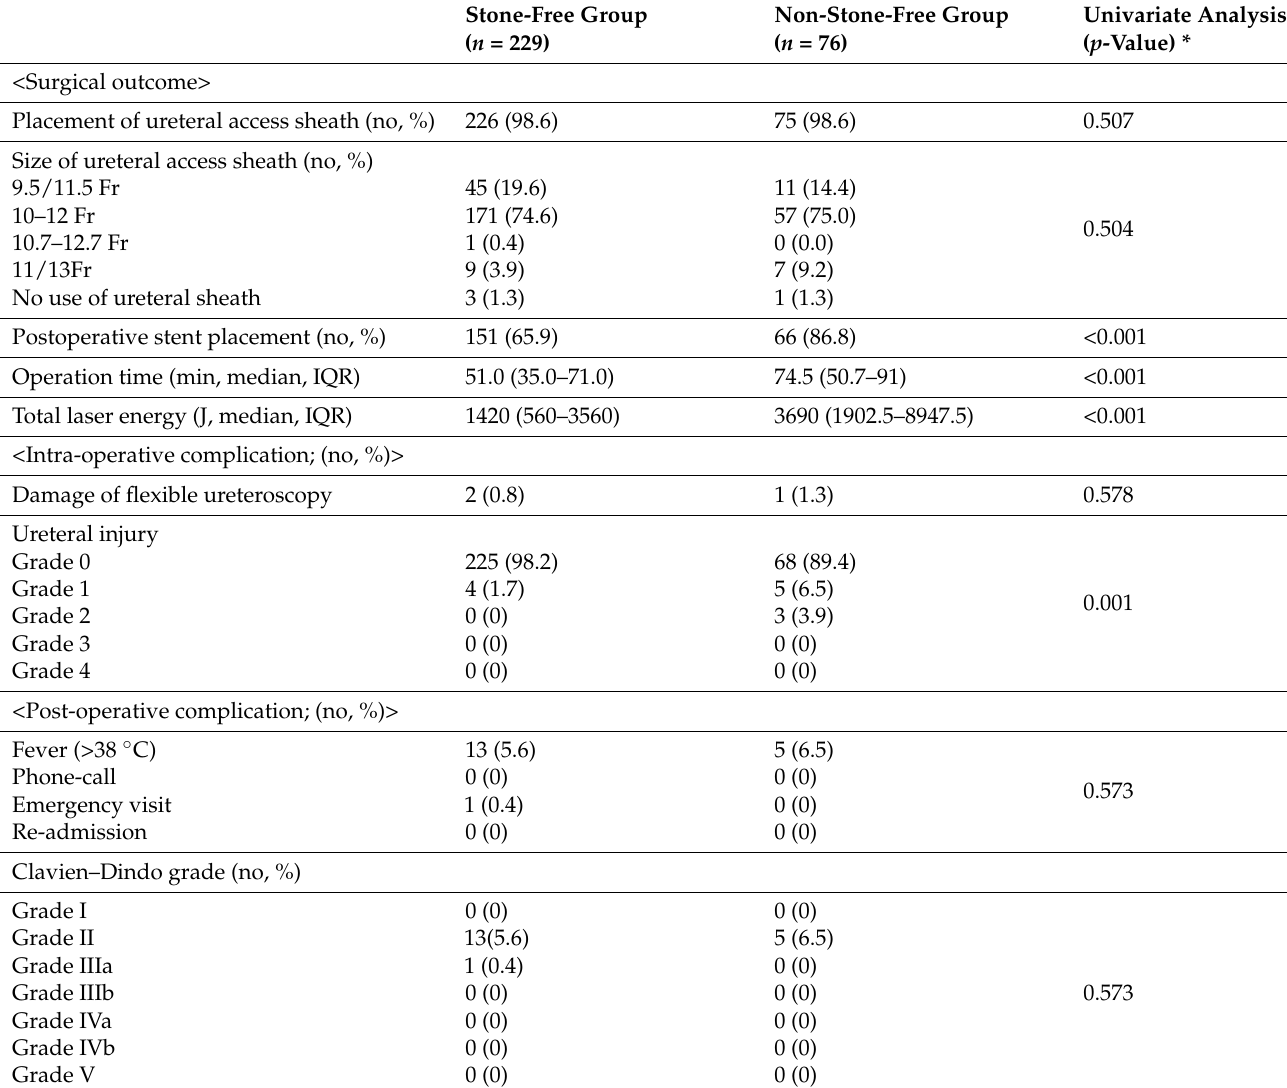
Table 2. Surgical outcome and post-operative complications in stone-free status. Stone-Free Group Non-Stone-Free Group Univariate ( n = 229)